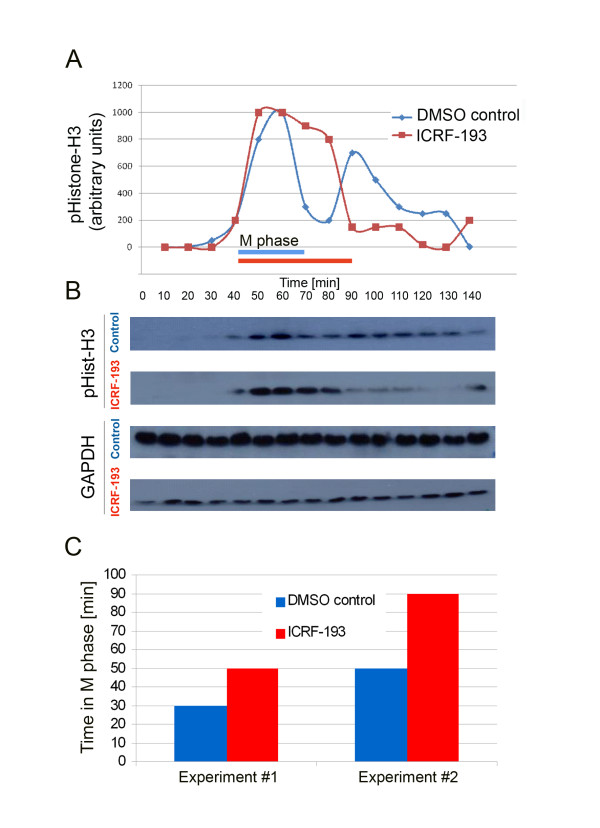
Inhibition of maternal Top2a in pre-MBT cycling extracts delays cell cycle progression by lengthening the M-phase. A) Cycling extracts from activated Xenopus eggs were treated with 20 μM Top2a inhibitor ICRF-193 diluted in 1% DMSO. To monitor cell cycle progression samples were taken every 10 minutes and phospho-histone H3 expression relative to GAPDH expression plotted. Blue and red bars indicate M phase in DMSO control and ICRF-193 treated extracts, respectively. B) Western blot analysis of phospho-Histone H3 and GAPDH expression levels. C) The increase in M phase length in two different cycling extracts treated with ICRF-193. M phase lengthened on average by 40% (SD = 3.14).